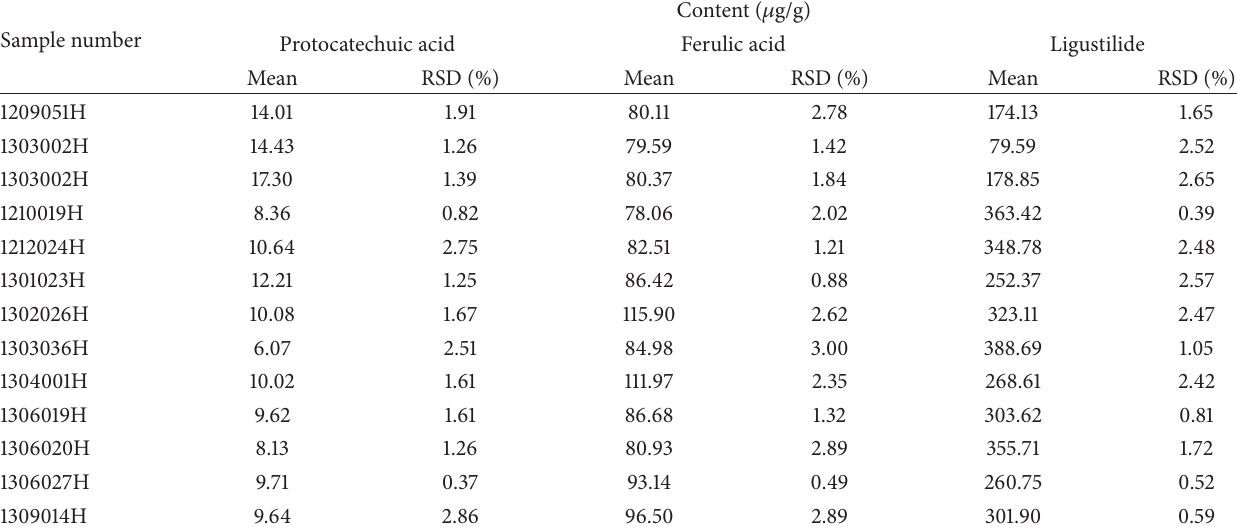
Table 4: Determination of the contents of protocatechuic acid, ferulic acid, and ligustilide of 13 batches of ZTPs.